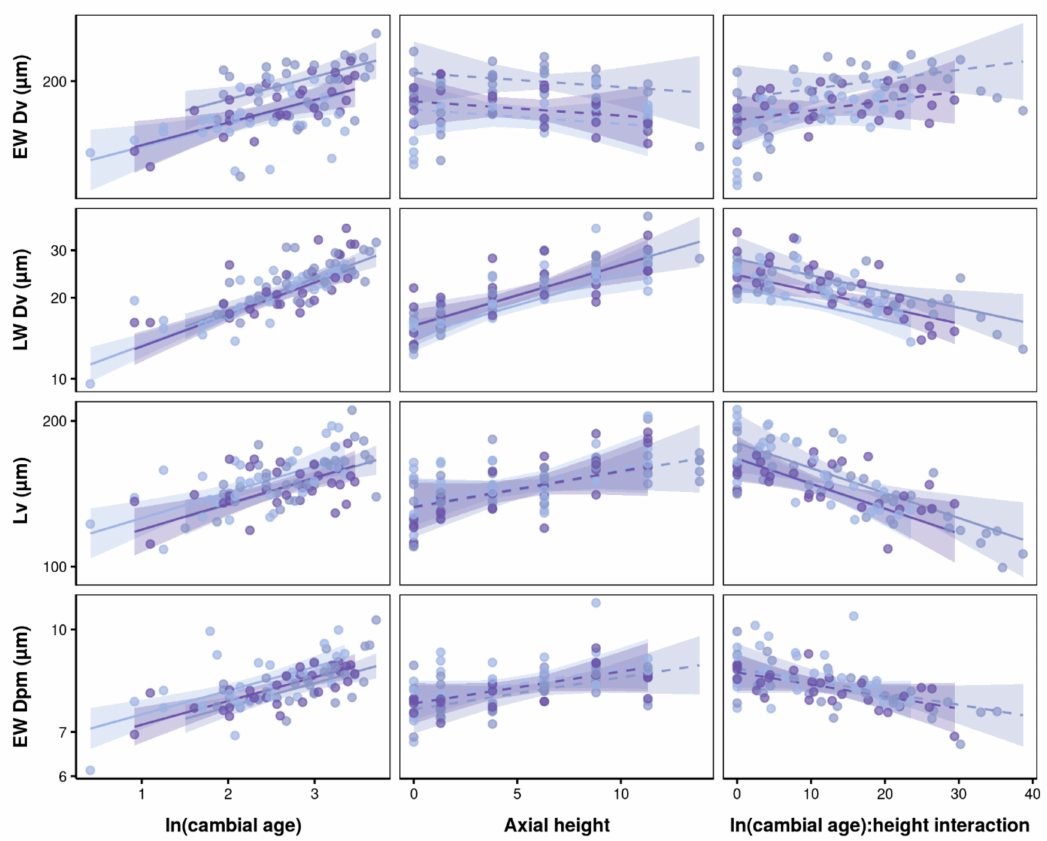
Figure 5. Partial residual plots for the models of vessel related traits. The predictions and 95% confidence intervals for each observed value of all three continuous predictor sare shown while keeping the other predictors at the average value of the corresponding tree, and partial residuals corresponding to the theoretical values of the response that would be observed when the other predictors were at their average value. Colors represent di ff erent trees; significant relationships are illustrated by solid lines while insignificant relationships are illustrated by dashed lines. EW: earlywood, LW: